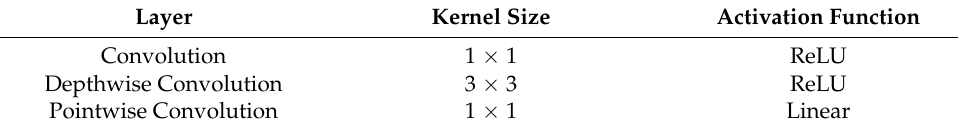
Figure 4. Structure of single feature extraction network. Table 1. Structure of improved depth separation module.